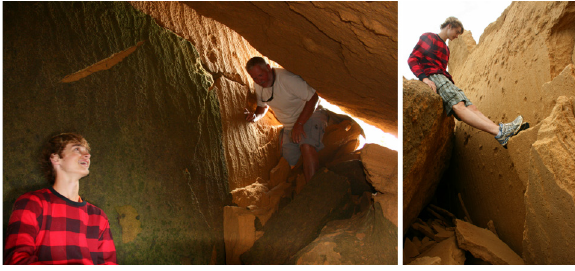
Figure 4: Exploring the gap between the seaward and landward portions of Roberts Rock in 2009. Numerous tracks are evident.